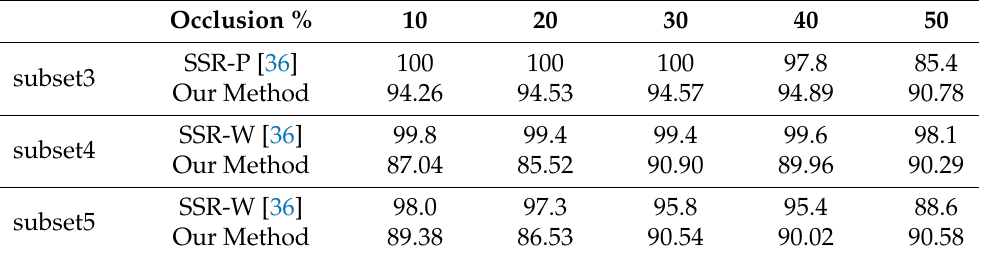
Table 2. Comparative analysis of the proposed approach using the Extended Yale B Datatset.